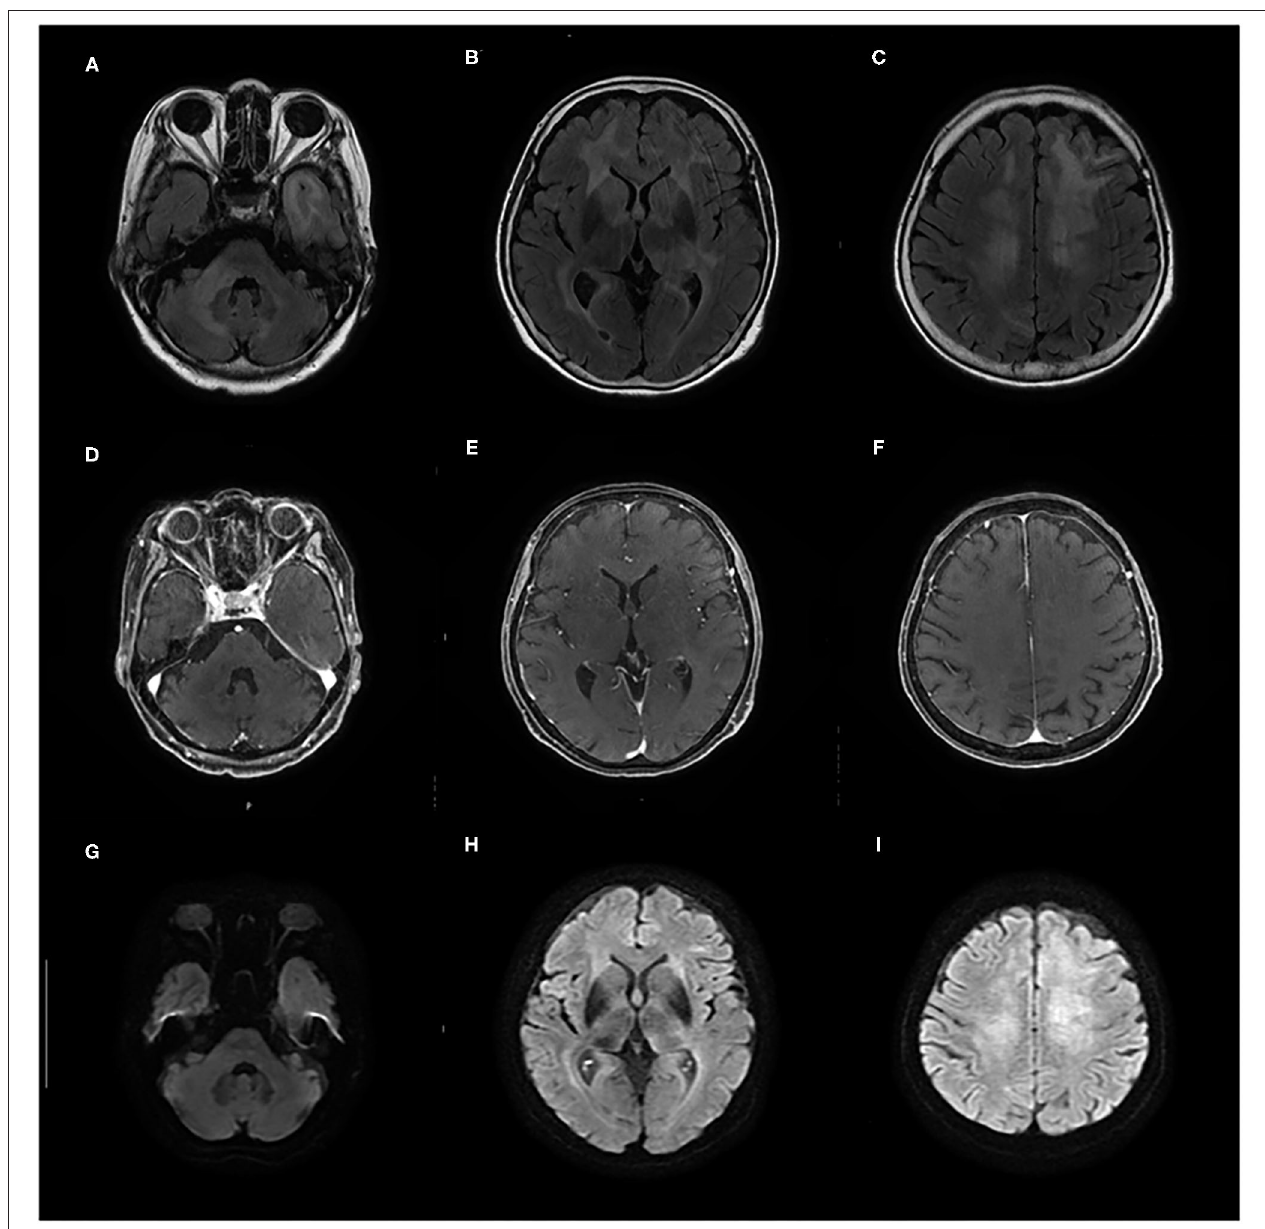
FIGURE 1 | (A–F) Contrast-enhanced brain MRI taken on admission shows diffuse T2/fluid-attenuated inversion recovery (FLAIR) hyperintense lesions in bilateral cerebral white matter, left temporal pole, and right middle cerebellar peduncle without gadolinium enhancement. (G–I) On diffusion-weighted imaging (DWI), these lesions show faintly high intensities that can be explained by T2 shine-through.